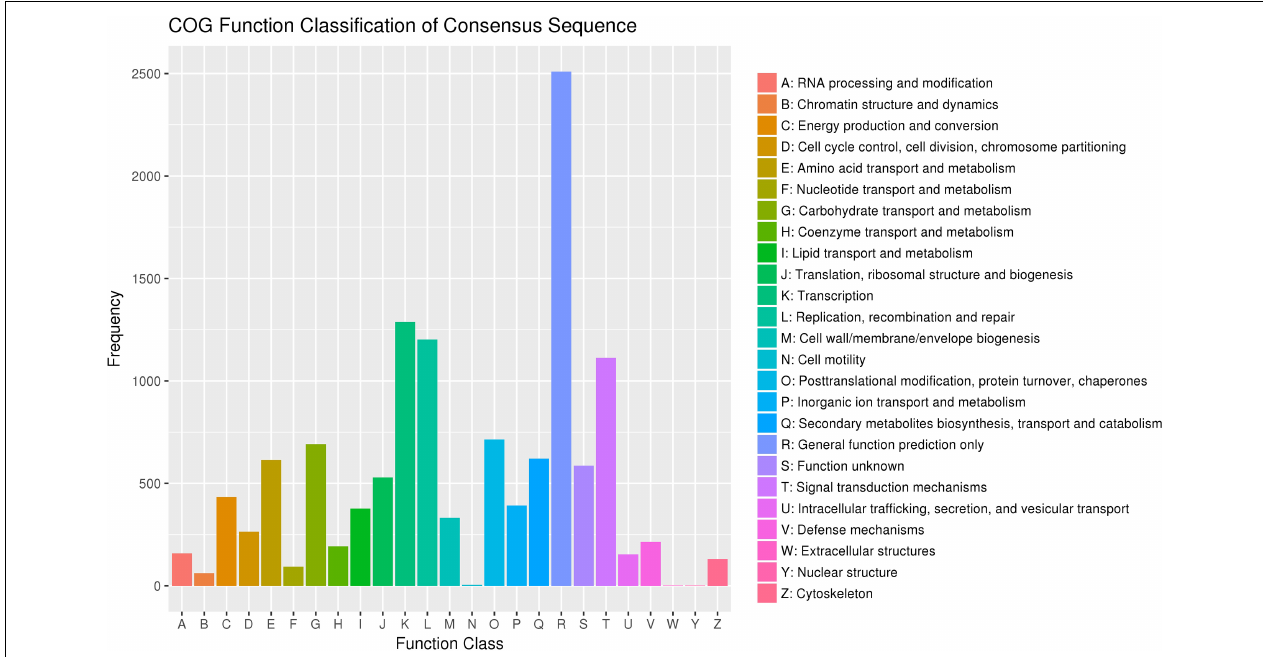
FIGURE 5 | The SNPs of Munake grape annotated according to the COG database, the x-axis shows the taxonomical content of COG data. The y-axis shows the number of genes.